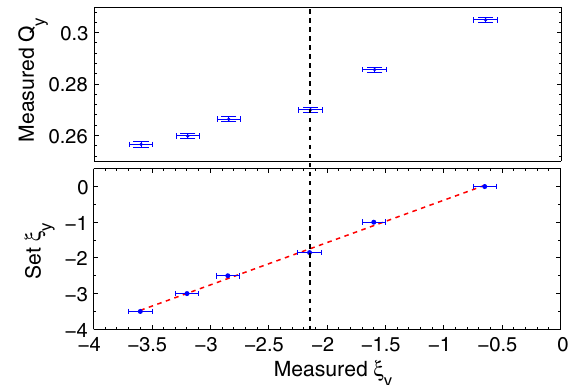
FIG. 24. Relative signal amplitudes of various head-tail modes are plotted with respect to the coefficient of Bessel’s function in Eq. (3) ( (cid:2) f ¼ (cid:2)= 2 ). All the modes are relative to the k ¼ 1 mode, which has a significant amplitude during the whole measurement